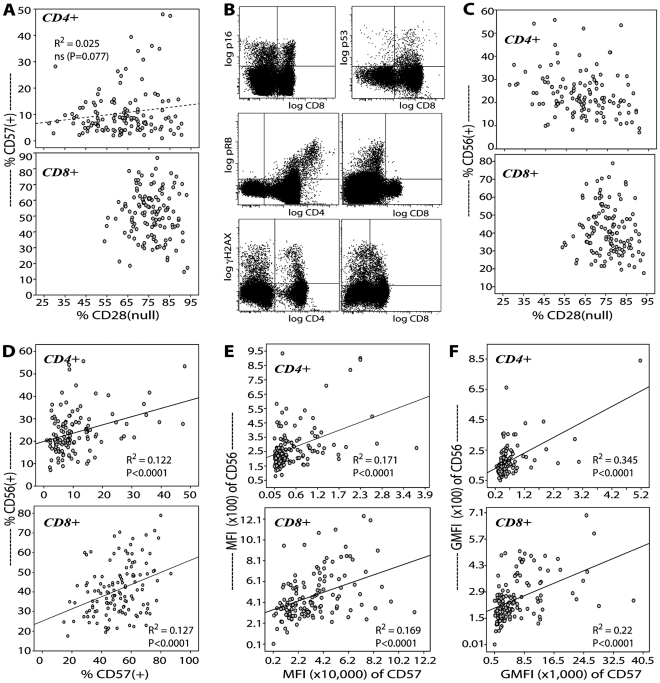
CHS All Stars elders display classic features of aging in the T cell compartment.By multicolor flow cytometry, CD3+ TCRαβ T cells in PBMC were examined for senescence-associated loss of expression of the costimulatory receptor CD28, and gains of expression of the adhesion molecule CD57 and the prototypic NKR CD56, as well as the expression of senescence antigens p16, p53, pRB, and γH2AX. (A) Scatter plot of the frequencies of CD28null and CD57+ cells in the CD4 and CD8 T cell compartments. (B) Representative profiles of p16, p53, pRB, and γH2AX expression in CD4 and CD8 T cells. (C) Scatter plot of the frequencies of CD28null and CD56+ T cells. (D, E, F) Scatter plot of the levels of expression of CD56 and CD57 measured as cell frequencies (D), as MFI (E), and as GMFI (F) in the CD4 and CD8 T cell compartments. Solid and dashed lines represent significant and non-significant regression lines, respectively, with the indicated R2 and p-values.